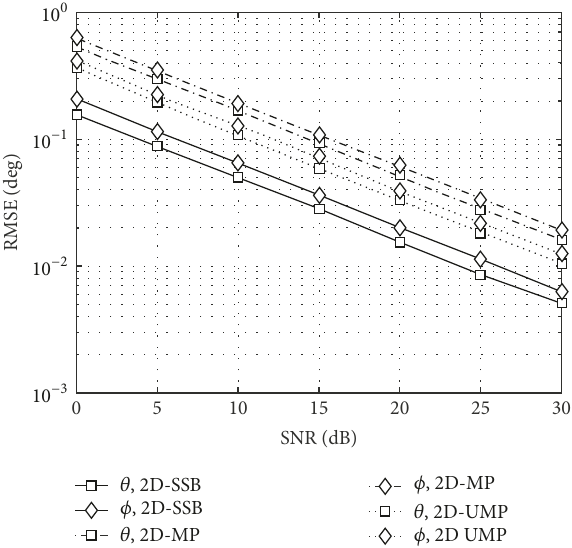
Figure 3: RMSEs of azimuth and elevation angles against with SNR for the closely positioned sources, where (𝜃 1 , 𝜙 1 ) = (10 ∘ ,12 ∘ ) and (𝜃 ,𝜙 ) = (12 ∘ , 10 ∘ ) . 2 2